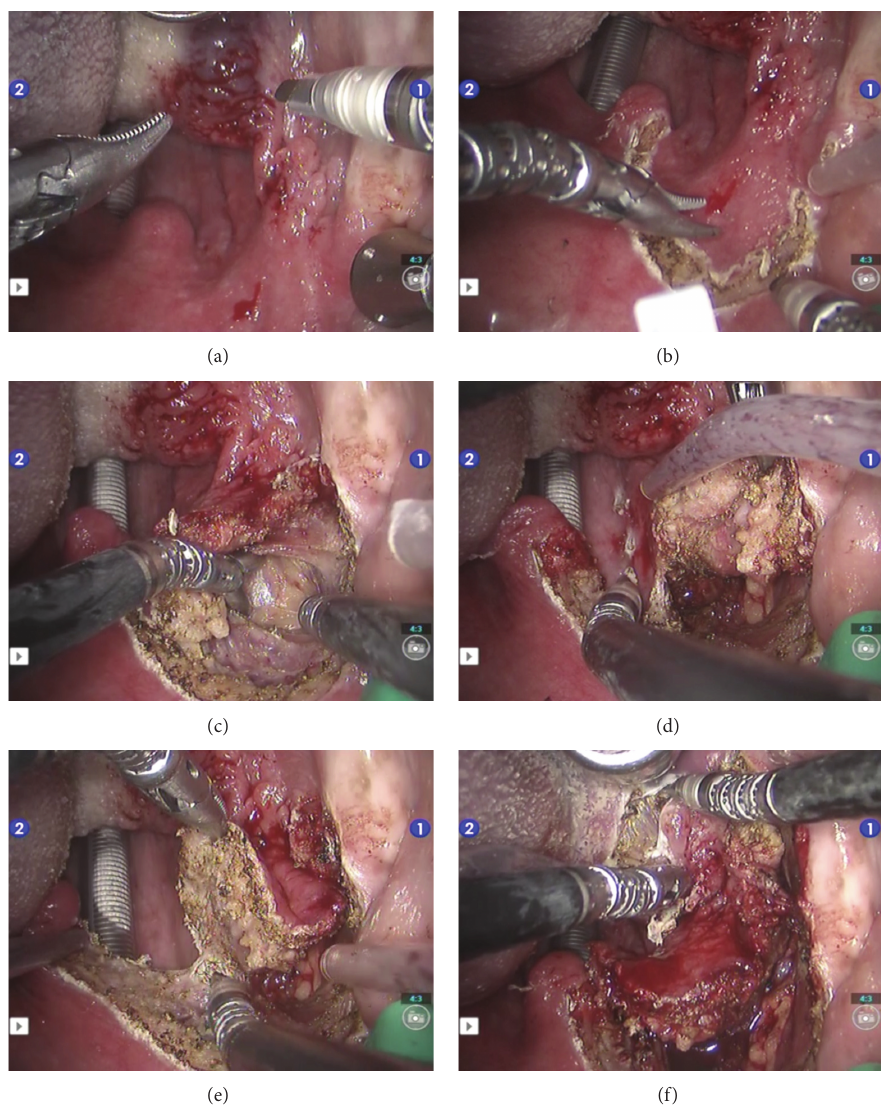
Figure 1: TORS radical tonsillectomy intraoperative views. Right hand: spatula tip monopolar cautery. Left hand: Maryland dissector (left- right, top-down). (a) Right tonsil epidermoid carcinoma extending to the anterior tonsillar pillar and tongue base. (b) Mucosal incision with a wide arch in the soft palate to fall laterally to the constrictor muscle. (c) Lateral limit: dissection of the parapharyngeal fat, which is pushed laterally off the constrictor. (d) Medial limit: posterior pharyngeal wall. (e) Superior limit: soft palate cut. (f) Inferior limit: tongue base